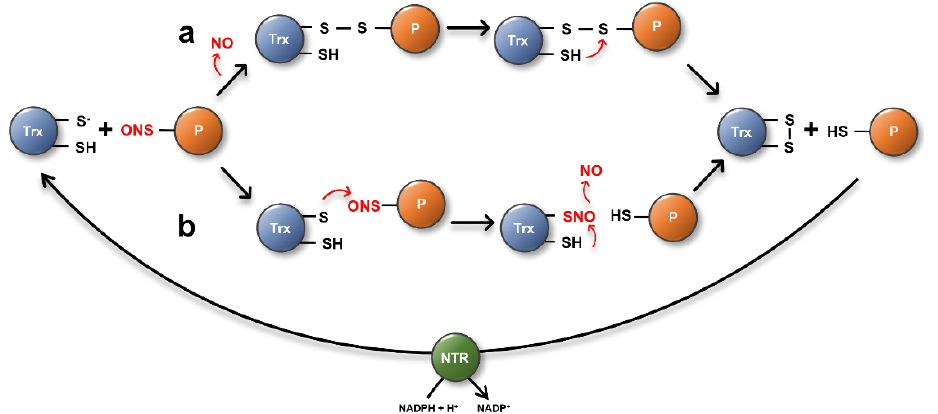
Figure 4. Proposed TRX denitrosation mechanisms via the reductive ( a ) or transnitrosation pathway ( b ). In the reductive pathway ( a ), the nucleophilic Cys residue of the TRX displaces NO from the target Cys by heterolytic cleavage, resulting in the formation of an intermolecular disulfide bond